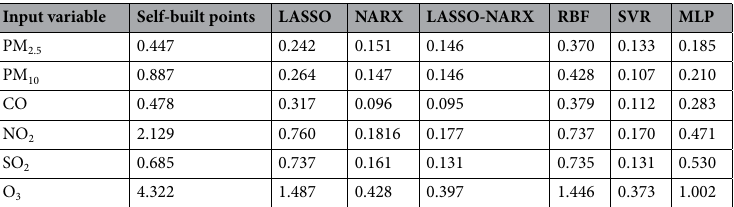
Table 7. MAPE of six types of air pollutant concentrations between self-built points, model forecast values and national control